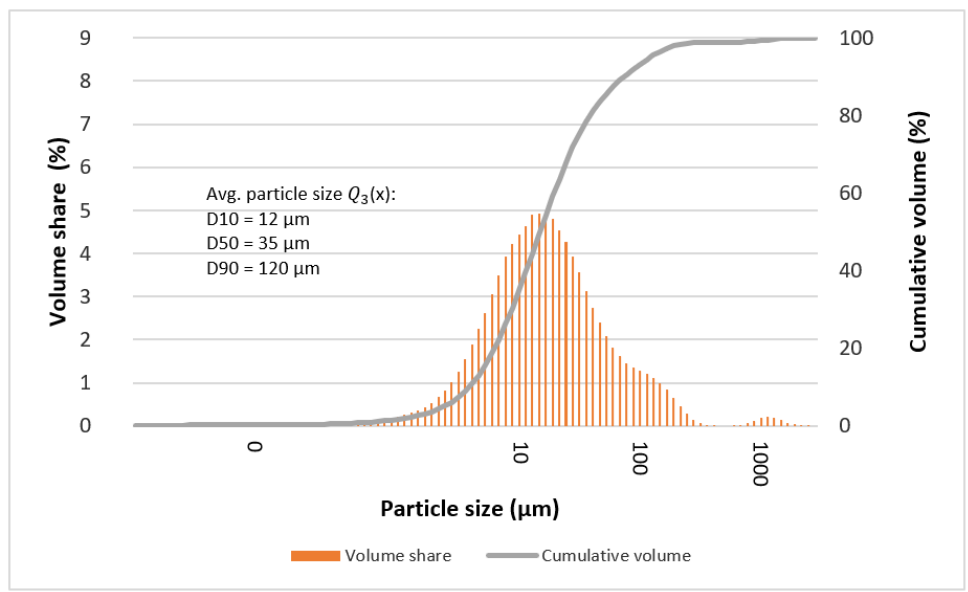
Figure 12. Graphs of particle size distributions (histograms) and their cumulative distribution (curve) for Mg 64 Zn 30 Ca 4 Ag 2 alloy after 70 milling hours.